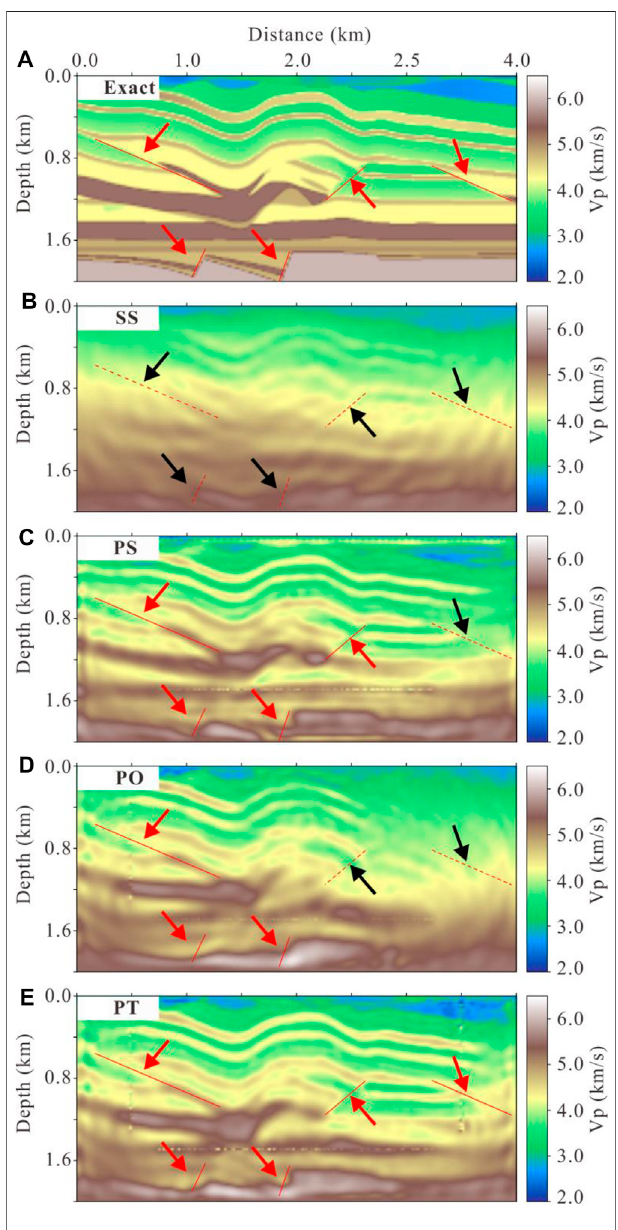
FIGURE 14 | Comparison of fault structures from the exact velocity model (A) . Inversion results of SS (B) , PS (C) , PO (D) , and PT (E) . Red arrows in (A) indicate the location of complex fault structures (solid red lines). (B – E) Red arrows indicate the successfully imaged fault structures (solid red lines), while the black arrows indicate fault structures that failed to recover (dashed red